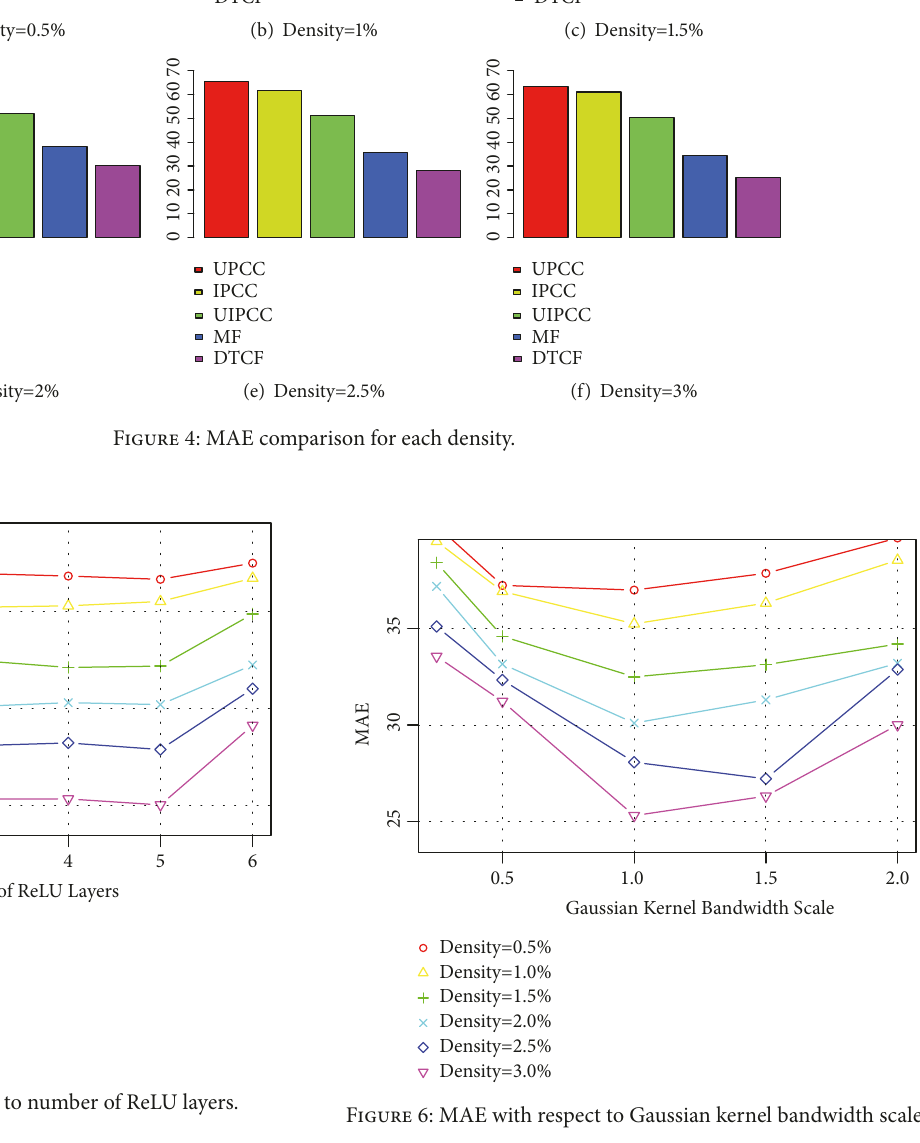
kernel bandwidth. By default, it is set to the median pairwise distance on the source training data. We scale the default value from 0.25 to 2.0, and the experimental result is outlined in Figure